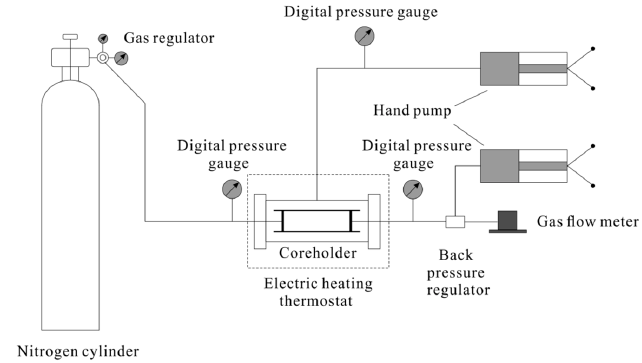
Figure 2. Schematic diagram of the experimental setup.